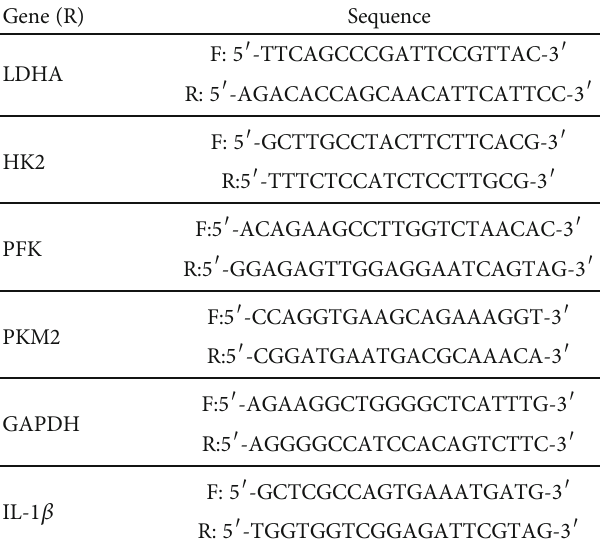
Table 1: Primer sequences for